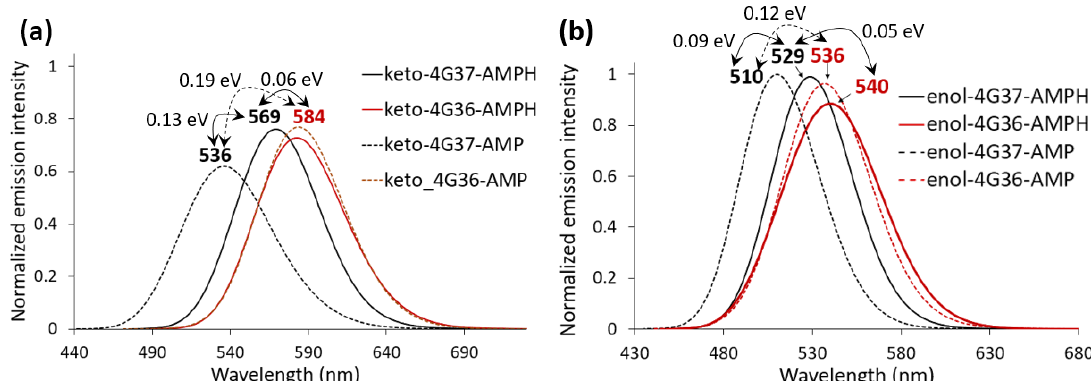
Figure 7. Simulated emission spectra, which intensity has been normalized considering the most intense spectrum (enol-4G37-AMP) as the reference value of 1, changing the protein conformation and protonation state of AMP for ( a ) phenolate-keto and ( b ) phenolate-enol chemical forms of